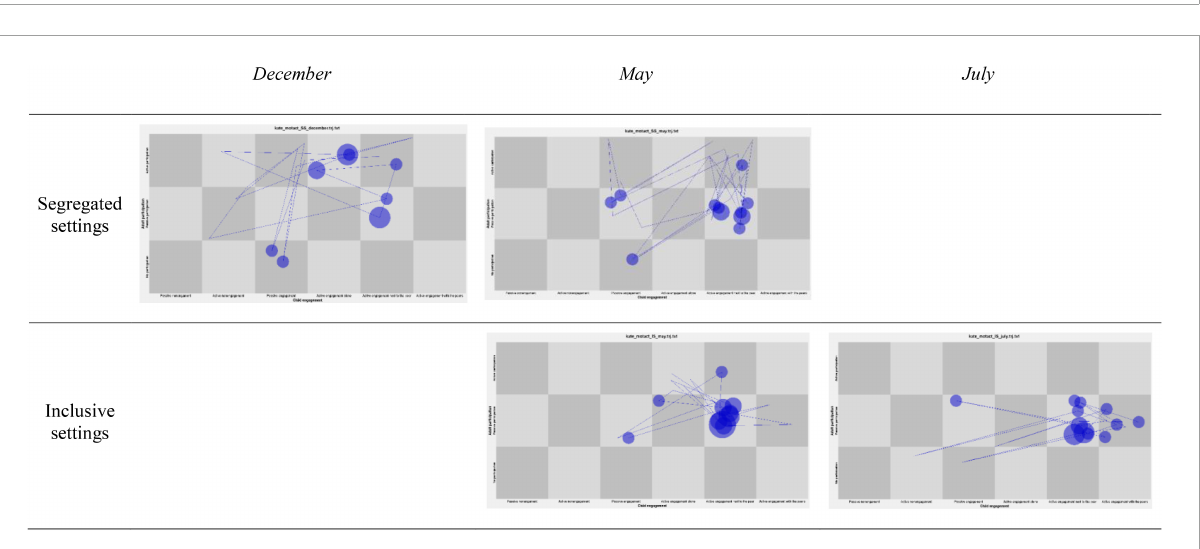
FIGURE2 State space grids during gross motor